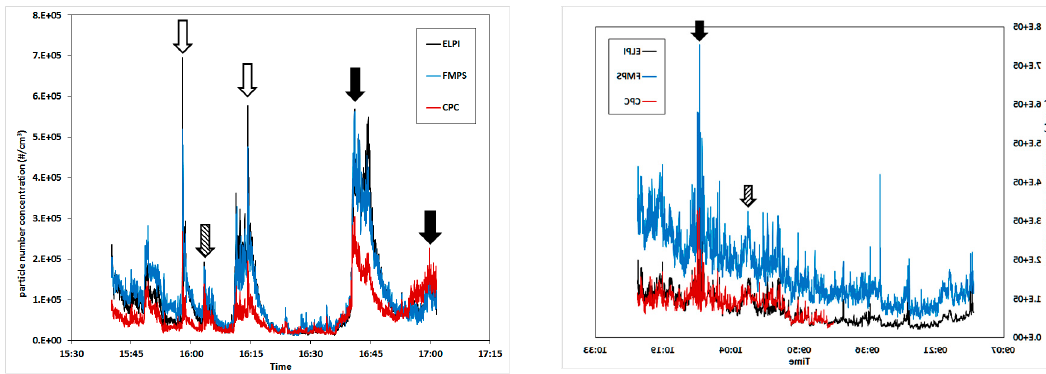
Figure 2. PM concentration as a function of collection time from the two different days of measurement. CPC, FMPS, and ELPI are compared and PM-increasing events are market by arrows. Results from day 1 are shown to the left, day 2 to the right.